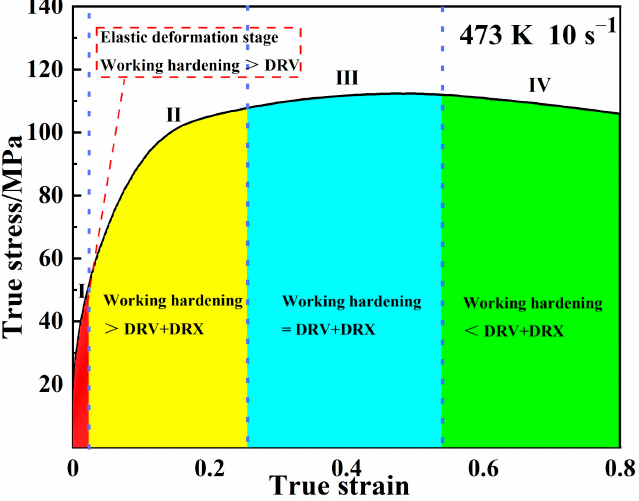
Figure 3. The shape of the true stress − strain curve and the relationship between different deformation.